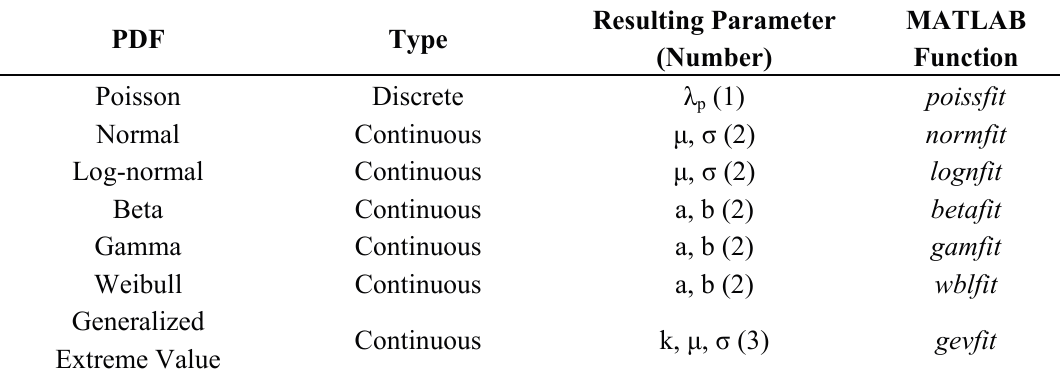
Table 3. Available probability distribution functions (PDFs) for pixel-wise fitting in ARCTIS. The number of free parameters per PDF type is indicated in the third column. When visualizing the ≥ 2 parameters in ARTICS as false color composites, the indicated order is used for red, green, and